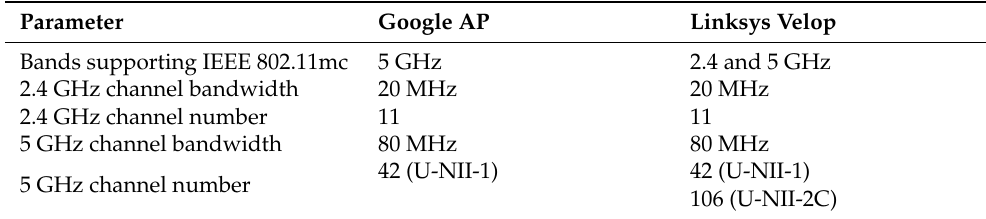
Figure 2. Detailed interior view of the auditorium at EETAC. Table 2. AP configuration